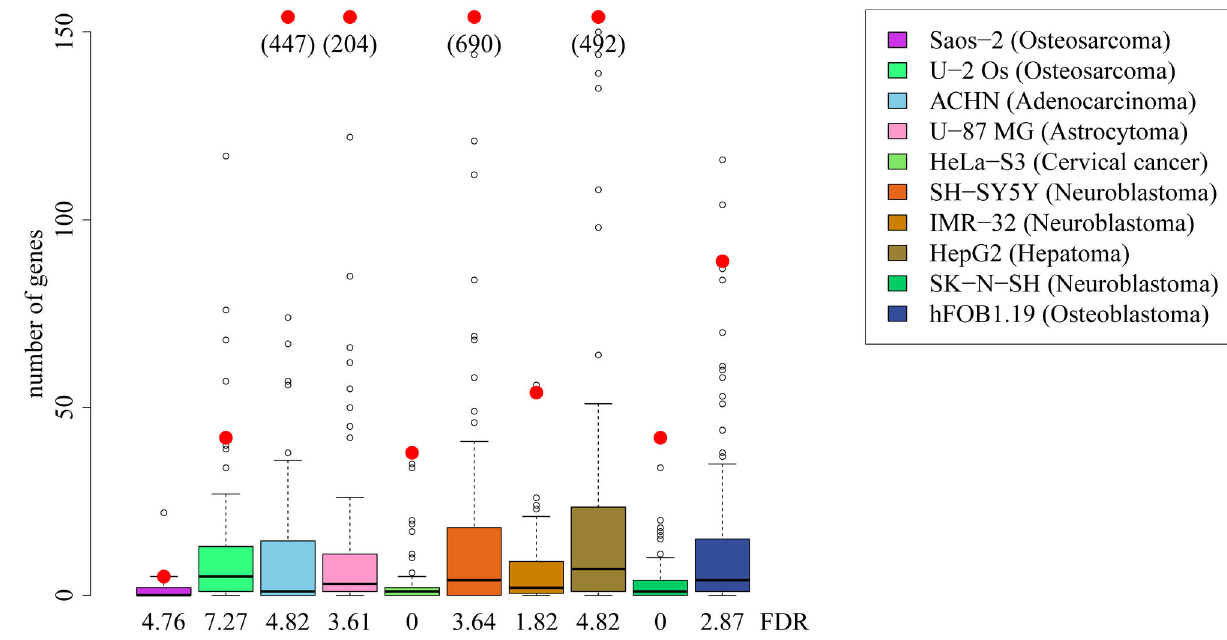
Figure 1. Differentially expressed genes. Number of differentially expressed genes after transfection with RUNX2 (red dots), compared to number of genes after permutation of sample labels. Note that values for differentially expressed genes above 150 are shown in